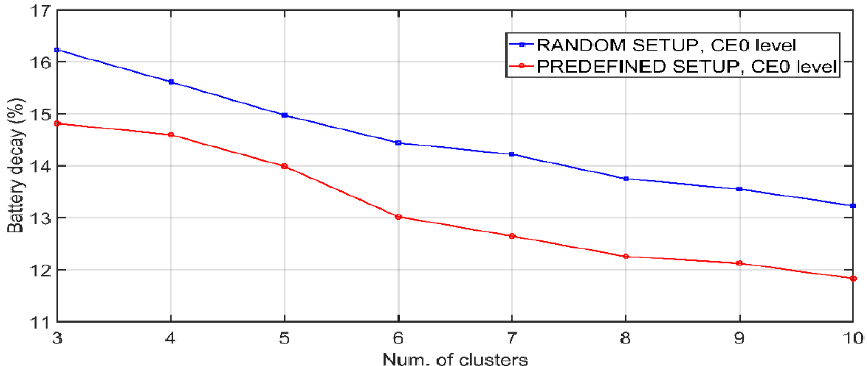
Figure 7. Annual battery decay of the combined network as a function of the number of clusters.